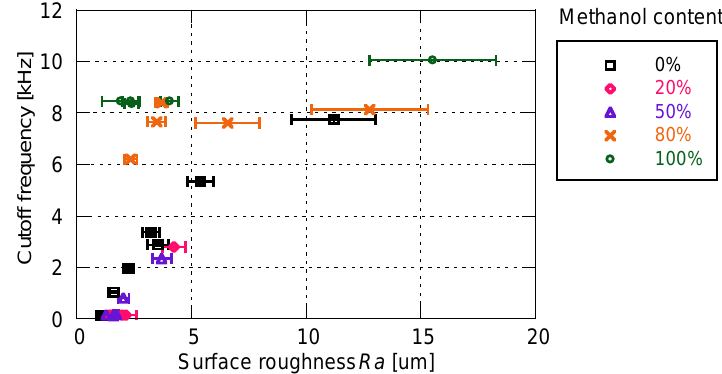
Figure 10. Relationship between cutoff frequency and surface roughness for the PD-adsorbed PSP with mixed solvent for particle/dye solution.